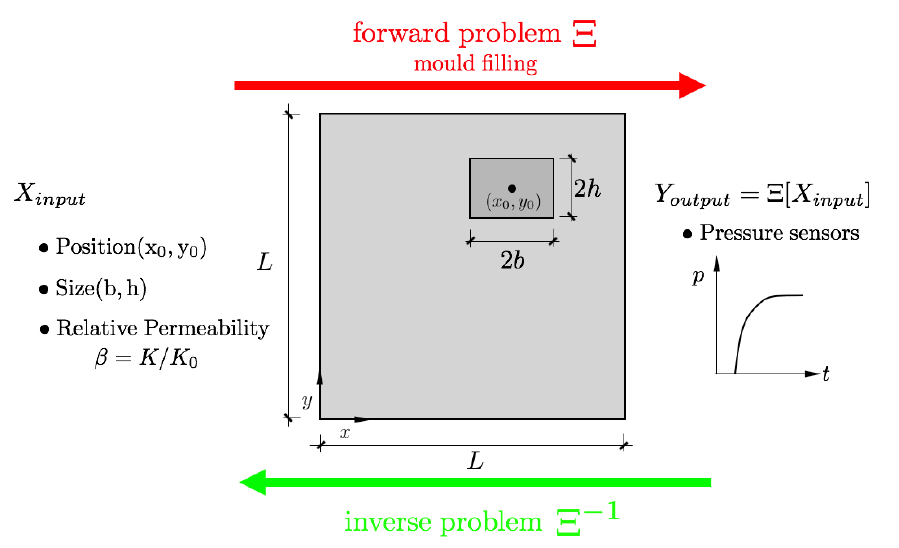
Figure 1. General description of the problem. Square RTM mould containing a rectangular dissimilar material region with relative permeability of β = K / K 0 , size 2 b stand for the permeability of the dissimilar region and the surrounding media,